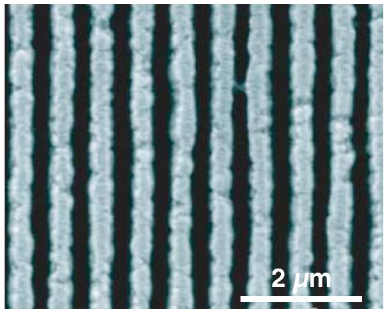
Figure 1. Scanning electron microscopy (SEM) image of a second-order diffraction grating for vertical coupling. The period of this grating is Λ = 674 nm, as shown by the scale bar. The metal layers are identical to the p-type metallization used for the contacts.